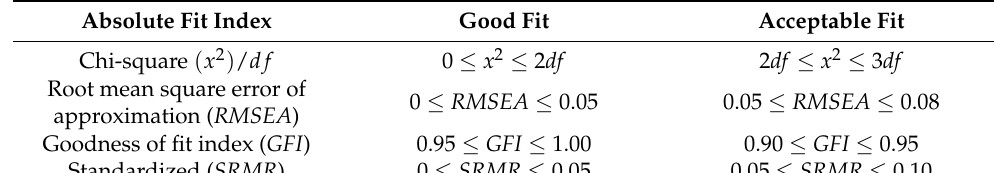
Table 12. Absolute fit index.